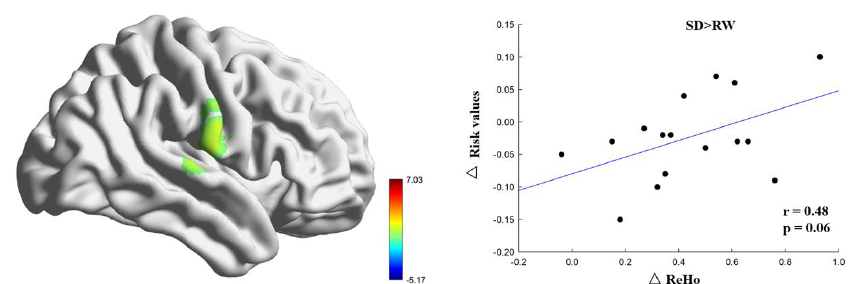
Figure 4. Regional homogeneity results. Regional homogeneity in the region of the right postcentral significantly increased following sleep deprivation. The corresponding brain region is illustrated at left, beside the scatter plot. Regional homogeneity (ReHo) change correlated with risk values change following sleep deprivation. SD, sleep deprivation; RW, rested wakefulness; BART, balloon analog risk